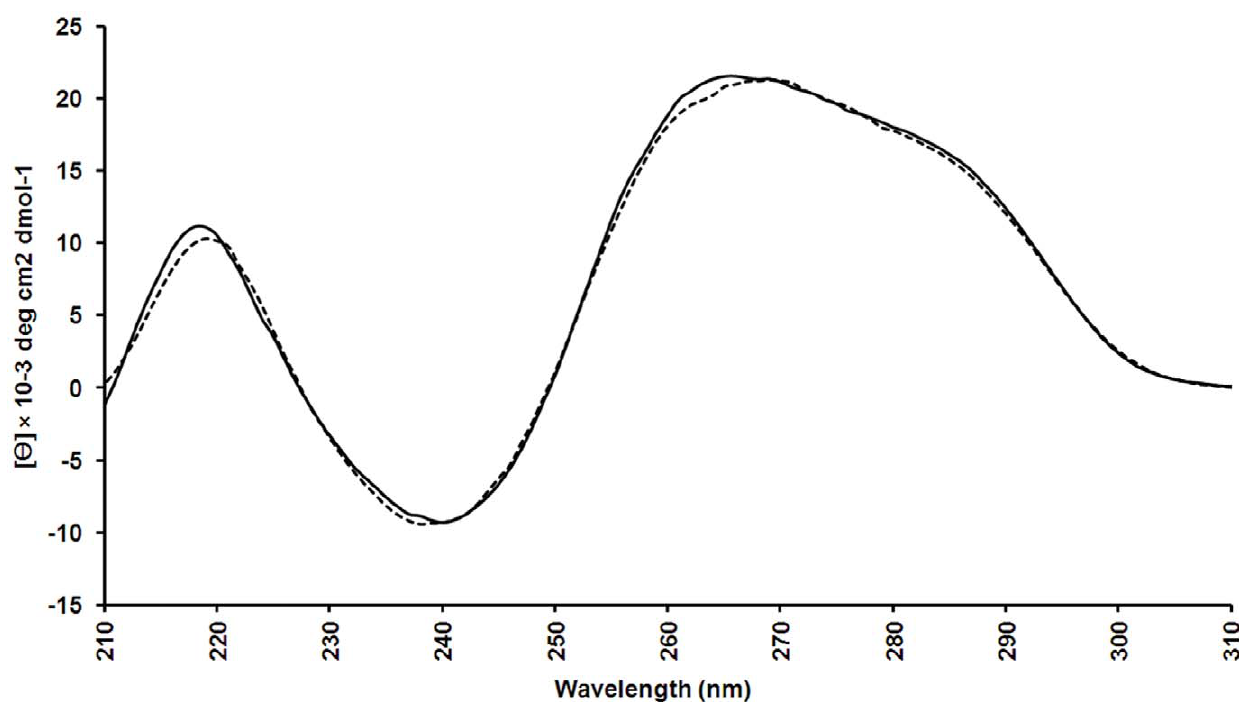
Figure 4. CD spectra of 10 m M PS-modified SL 2 -B aptamer in phosphate buffer saline (PBS) buffer, pH-7.2. Spectra were measured at 25 6 C (solid line) and 37 6 C (dotted line).